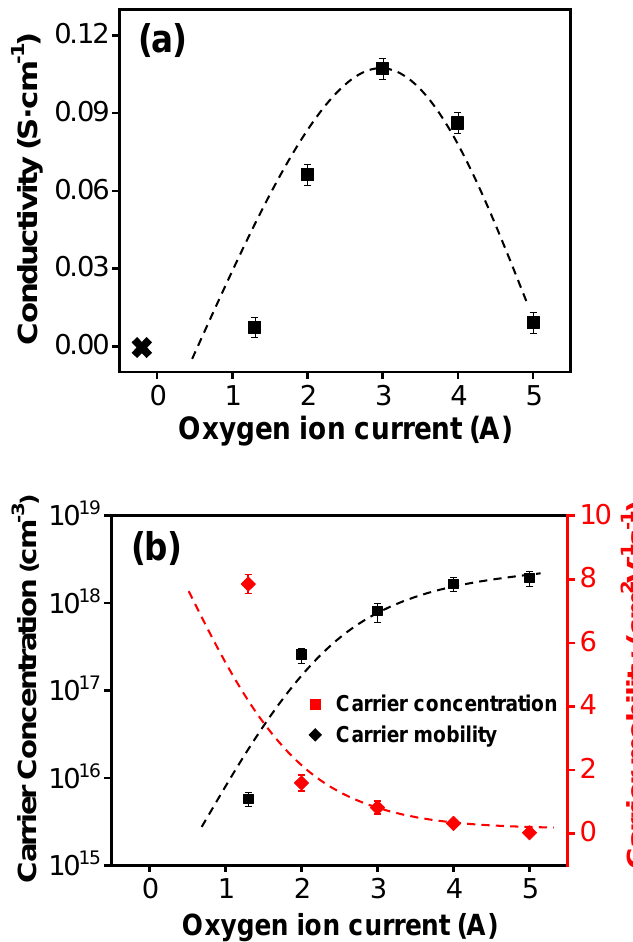
Figure 4. The ( a ) conductivity and ( b ) carrier concentration and carrier mobility of Cu 2 O films as a function of oxygen ion beam current.